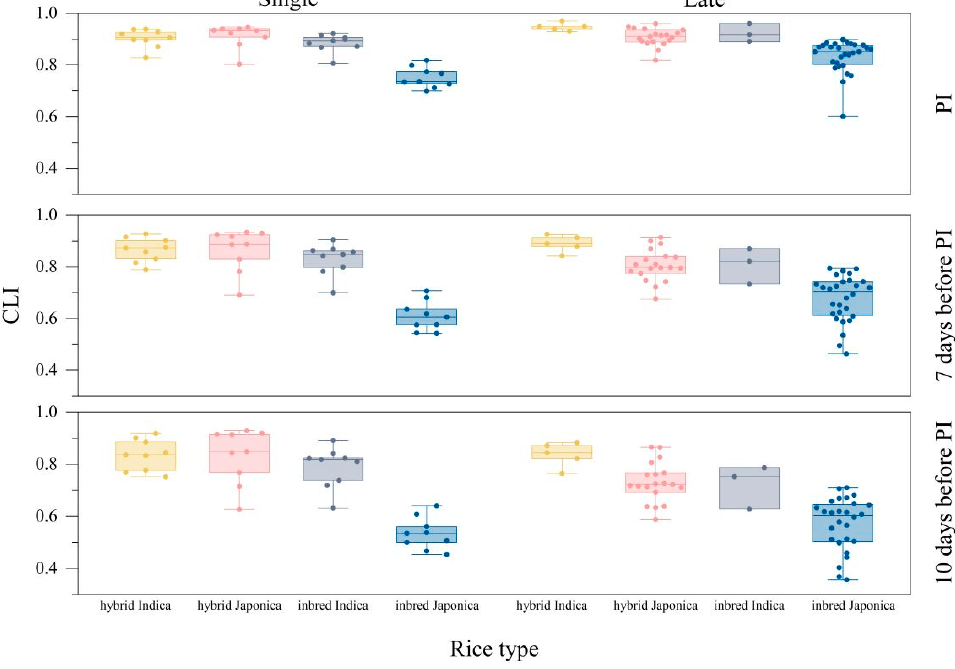
Figure 5. CLI values at PI and 7 and 10 days before